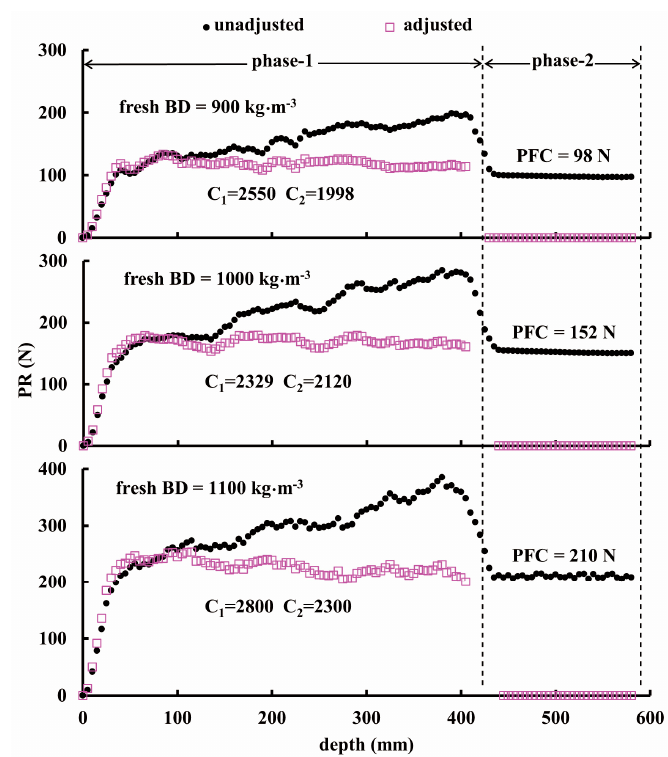
Figure 8. Results of penetrating chopped maize with different packed densities: ( a ) 900 kg·m − 3 , ( b ) 1000 kg·m − 3 , and ( c ) 1100 kg·m − 3 . Solid dots denote uncorrected PR data, hollow squares denote corrected PR data, i.e., PR c .